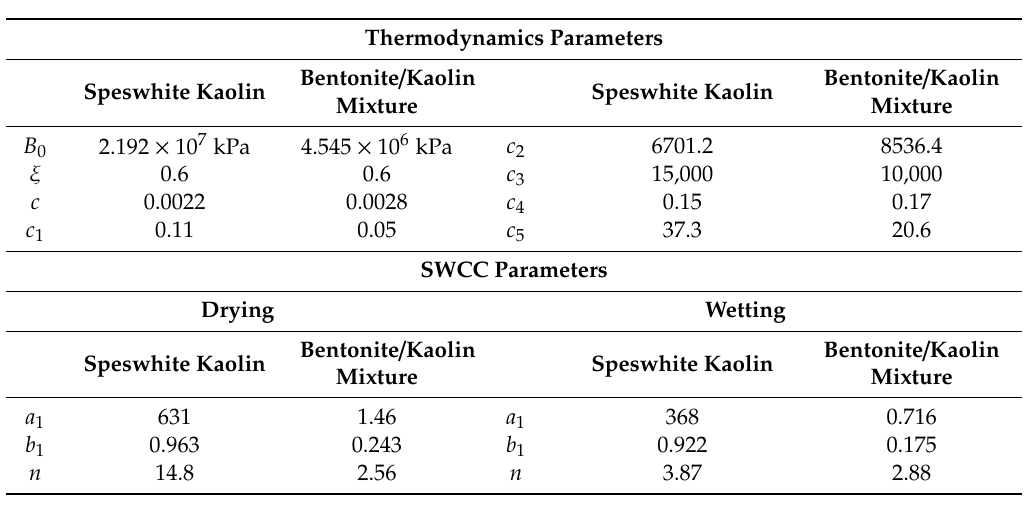
Table 1. Geotechnical materials types and model parameters. Soil-water characteristic curves (SWCC).